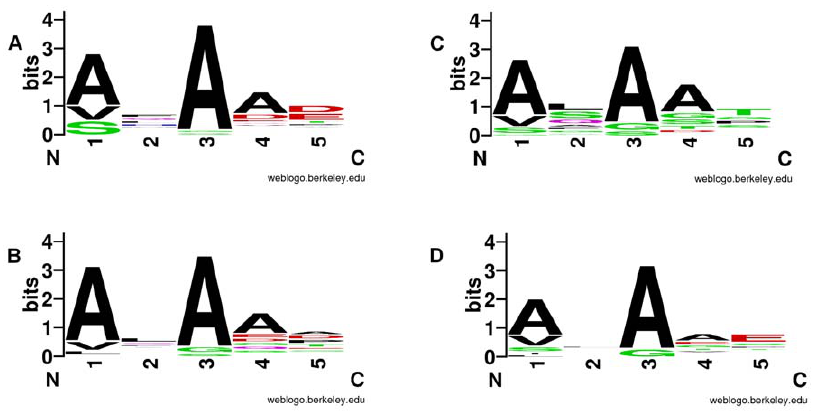
Figure 3. Signal peptidase I motifs. The amino acid residues surrounding signal peptidase cleavage sites are shown for four organisms. The five amino acid residues are three residues prior to cleavage ( 2 3, 2 2, 2 1) and two residues post cleavage ( + 1, + 2). A, E. coli ; B, Caulobacter crescentus ; C, Deinococcus radiodurans ; D, Cyanobacterium synechocystis . Figures were created using weblogo.berkeley.edu with default parameters.